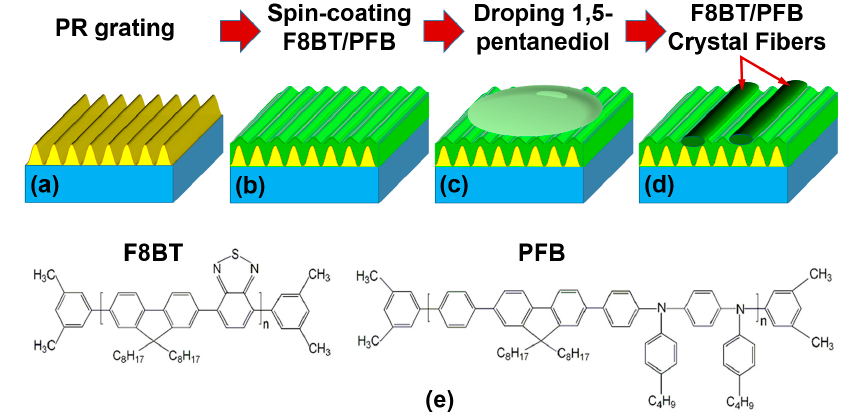
Figure 1. Fabrication procedures for the F8BT fibers. ( a ) The template PR grating with a period of 670 nm on a glass substrate; ( b ) spin-coating of the polymer film; ( c ) drop casting of 1,5-pentanediol onto the top surface of the polymer film; ( d ) growth of the polymeric fibers; and ( e ) chemical structures of F8BT and PFB.